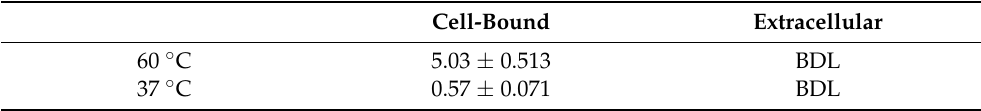
Figure 4. Alignment between phytase sequences of Mo40 (marine strain) and CBS 767 ( D. hansenii type strain). The different amino acids are indicated in blue, the conserved ones in red. Table 3. Phytase activity (mU/mg d.w ) detected in cells grown in the presence of phytic acid as the sole phosphorus source. Enzyme activity was assayed at pH